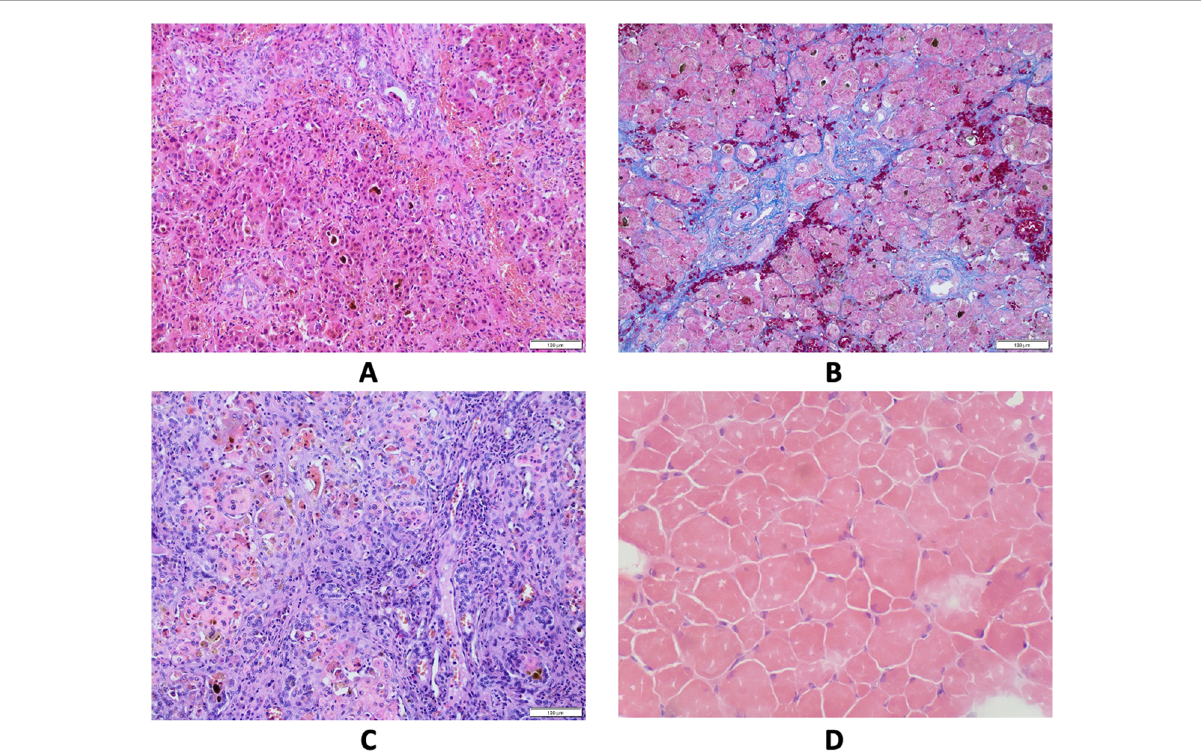
FIGURE 1 Results of pathological studies. ( A ) Liver core biopsy at the age 4 months showing mainly periportal fi brosis and cholestasis. Hematoxylin and eosin stain, original magni fi cation 200×. ( B ) Liver core biopsy at the age 7 months revealed progression of periportal fi brosis toward perisinusoidal pattern. AZAN stain, original magni fi cation 200×. ( C ) Explanted liver sample at cirrhotic stage. Hematoxylin and eosin stain, original magni fi cation 200×. ( D ) Skeletal muscle biopsy showing variability of muscle fi ber diameters. Hematoxylin and eosin stain, frozen section, original magni fi cation